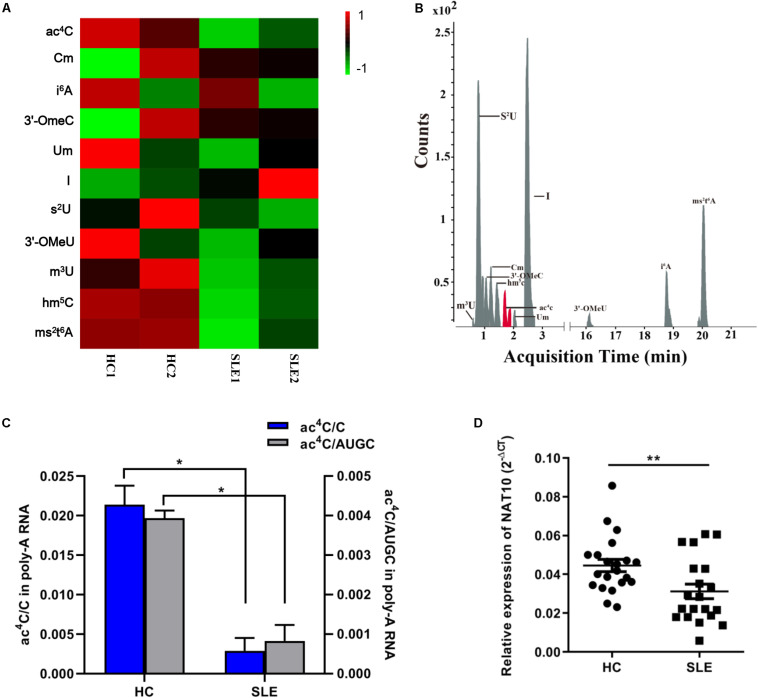
Overview of mRNA ac4C acetylation mapping between systemic lupus erythematosus (SLE) patients and healthy controls (HCs). (A) Heatmap of normalized abundance (modification/canonical nucleotide) of 11 mRNA modification forms detected through LC-MS/MS in CD4+ T cells from SLE patients and HCs. Green indicates a low z-score whereas red indicates a high z-score. (B). LC-MS/MS extracted ion chromatograms of modified mRNA in SLE patients and HCs. ac4C, N4-acetylcytidine; Cm, 2′-O-methylcytidine; i6A, N6-isopentenyladenosine; 3′-OmeC, 3′-O-methylcytidine; Um, 2′-O-methyluridine; I, inosine; s2U, 2-thiouridine; 3′-OMeA, 3′-O-methyladenosine; m3U, 3-methyluridine; hm5C, 5-hydroxymethylcytidine; ms2t6A, 2-methylthio-N6-threonylcarbamoyladenosine. (C) Comparation of calibrated ac4C/C and ac4C/AUGC levels in poly(A) RNA between HCs and SLE. Bars show the mean with SD of individual biological replicates (n = 2). *P < 0.05. (D) NAT10 mRNA expression level in CD4+ T cells from HCs (n = 21) and SLE patients (n = 20). Compared to HCs, NAT10 was downregulated in SLE patients. Data are presented as 2–ΔCt relative to GAPDH expression (mean with SEM; **P < 0.01).